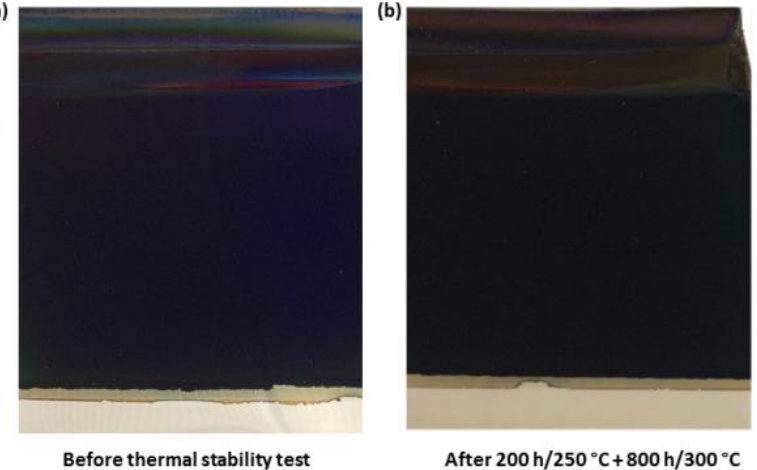
Figure 7. Photographs of the Al/CuMnO x /CuFeMnO x /SiO 2 (blower) selective absorber before ( a ) and after ( b ) the thermal stability test.